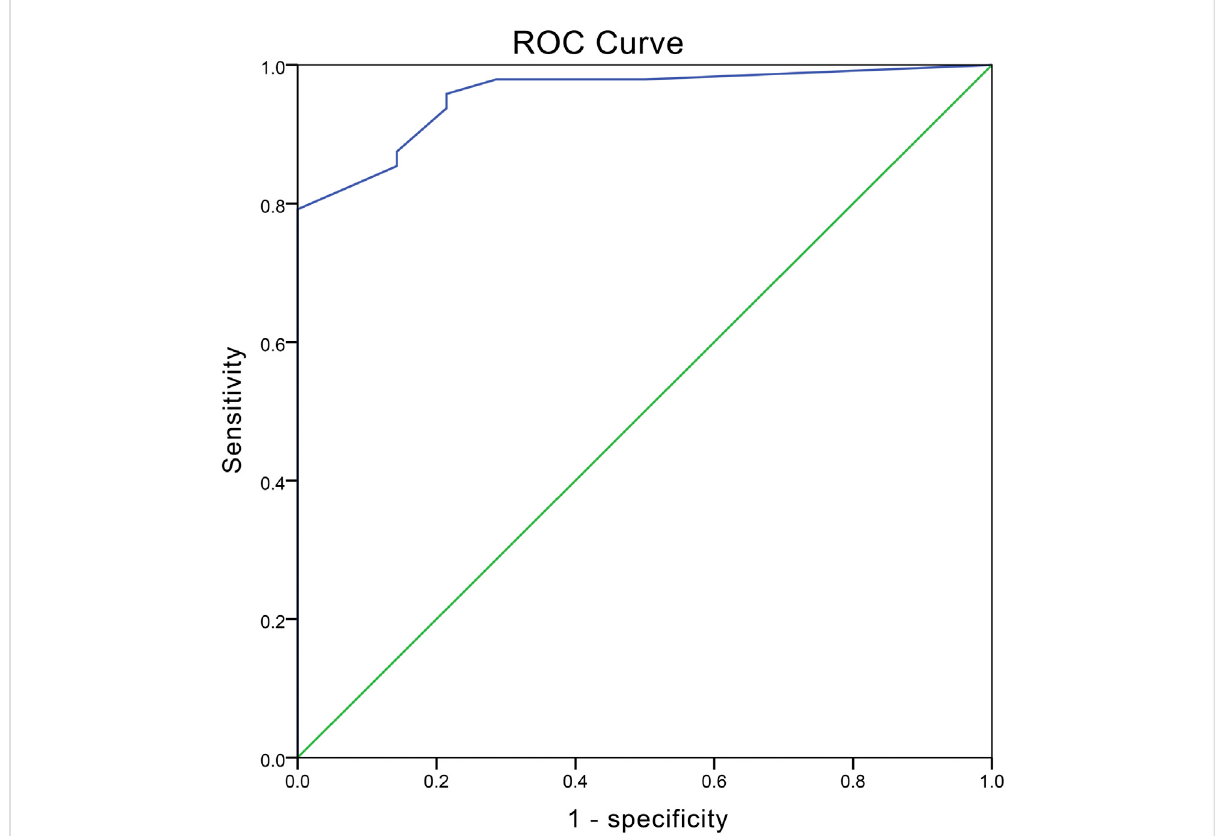
FIGURE 4 ROC curve depicting the diagnostic value of PLP1. The values of AUC, optimum cutoff, sensitivity, and speci fi city are 0.956 ( p < 0.001), 2.069, 79.2% and 100%,